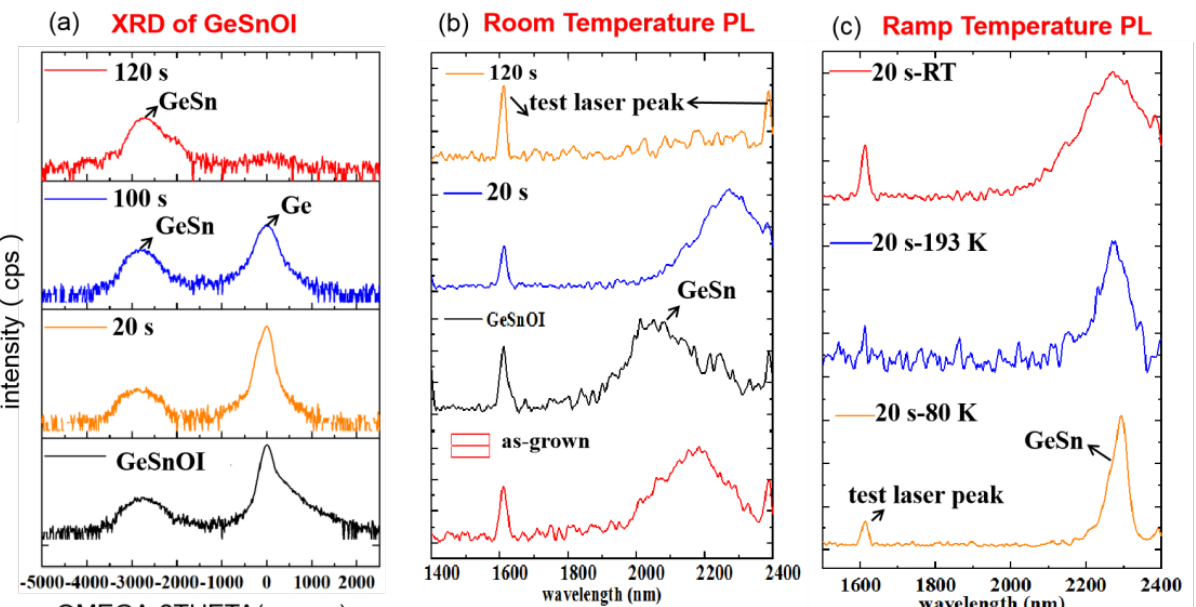
Figure 10. ( a ) XRD of GeSnOI as-grown (black line) and after wet etchings of 20 s (orange line), 100 s (blue line), and 120 s (red line); ( b ) PL at room temperature of GeSn as-grown (red line), GeSnOI (black line), and after wet etchings of 20 s (blue line), 100 s (amaranth line), and 120 s (orange line); and ( c ) PL of GeSnOI after wet etching of 20 s at temperatures of 80 K (orange line), 193 K (blue line), and room temperature (red line).